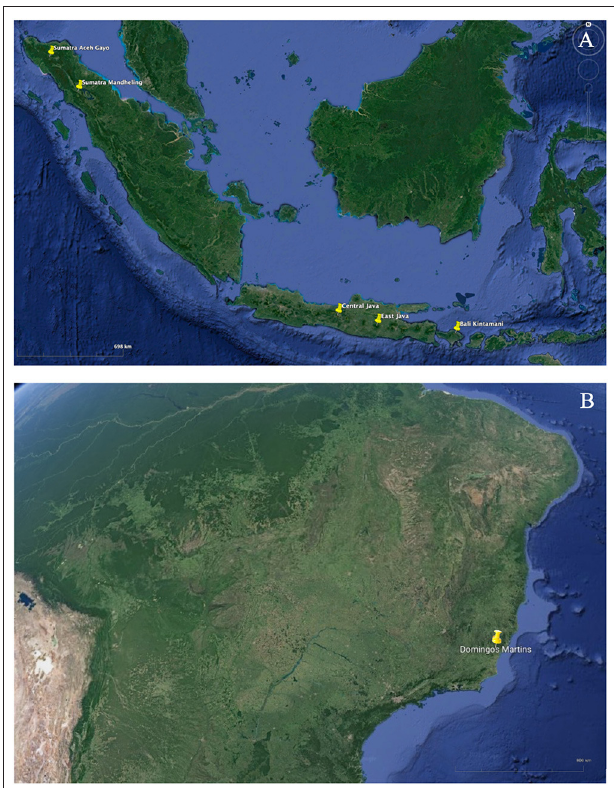
FIGURE 1 | Regions of Indonesia (A) and Brazil (B) from where Kopi Luwak and Jacu samples were obtained, respectively.